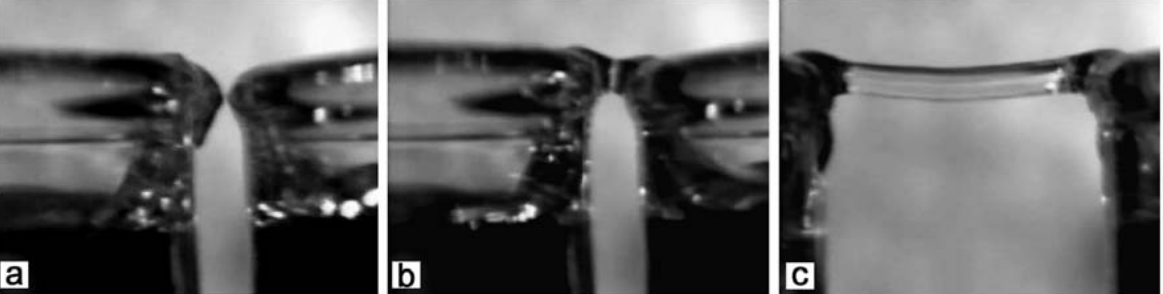
Figure 5. Water bridge formation: (a) rise of water in both beakers after a high voltage was applied and a first ignition spark was observed, (b) spontaneous formation of a connection which remains stable after (c) pulling the beakers apart (from